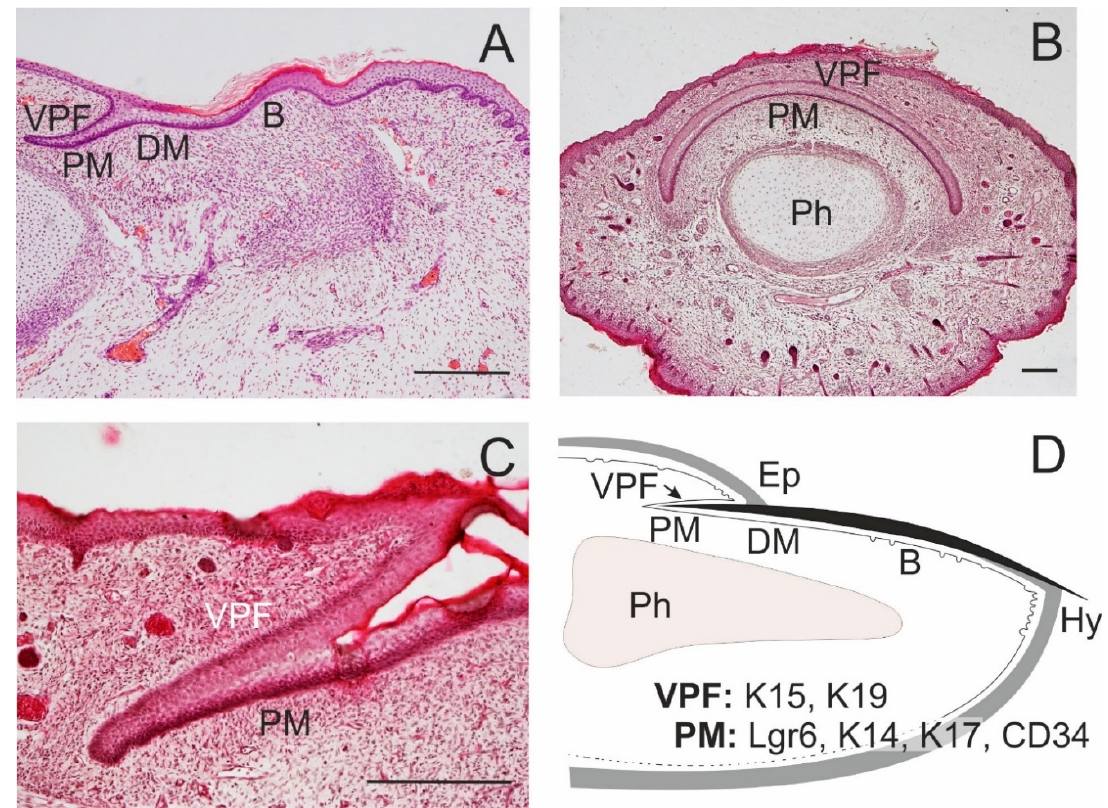
Figure 3. Formation of the nail. Nail proximal (PM) and distal matrix (DM) constitute a nail stem cell niche. In the dorsal side of a fingertip of a 14-week human embryo, a ventral proximal fold is in close association with PM; a nail bed ( B ) appears in continuation of the nail matrix ( A ). A transverse section of a distal tip of the little finger in a 17-week human embryo shows a curved course of PM, with overlying ventral proximal fold (VPF); distal phalanx (Ph; B ); a detail of the association of PM and VPF in a longitudinal section ( C ). A schematic drawing of the arrangement of epithelial structures associated with an adult nail, with the distribution of some SC markers; eponychium (Ep), hyponychium (Hy; D ). Scale bars 25 μ